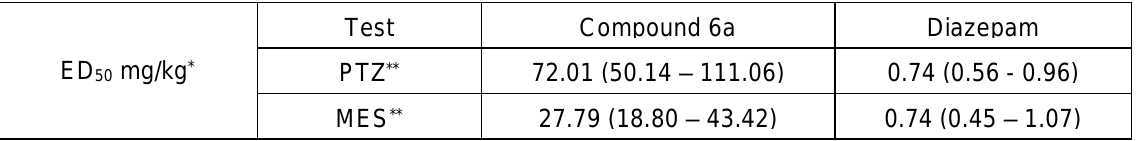
Table 2: PTZ-induced lethal convulsion and MES tests of the compound 6a